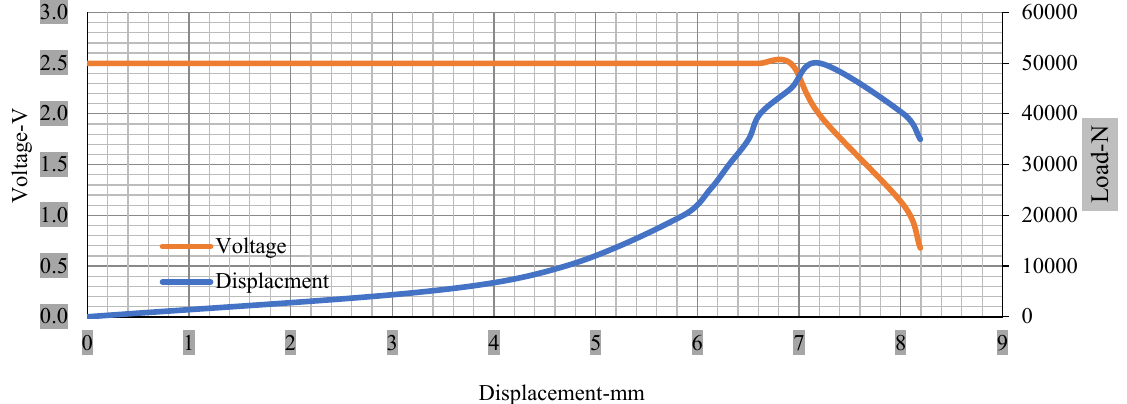
Figure 7. Load and voltage vs. displacement 25 mm punch greater than 10% soc.